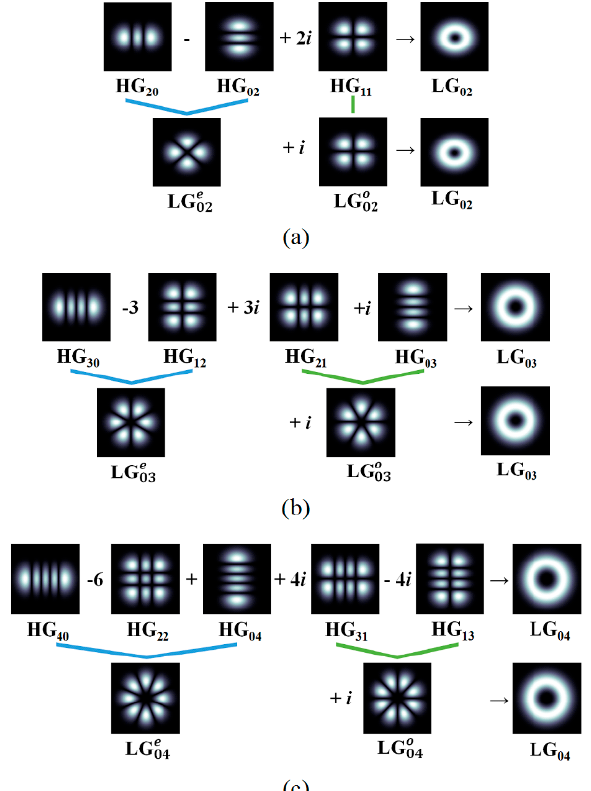
Figure 1. Decomposition of LG modes into HG modes: ( a ) l = 2; ( b ) l = 3; and ( c ) l = 4. In each case, HG modes of the same azimuthal symmetry are grouped and dubbed LG (cid:2868)(cid:3036)(cid:3032) and LG (cid:2868)(cid:3036)(cid:3042) according to their symmetry.